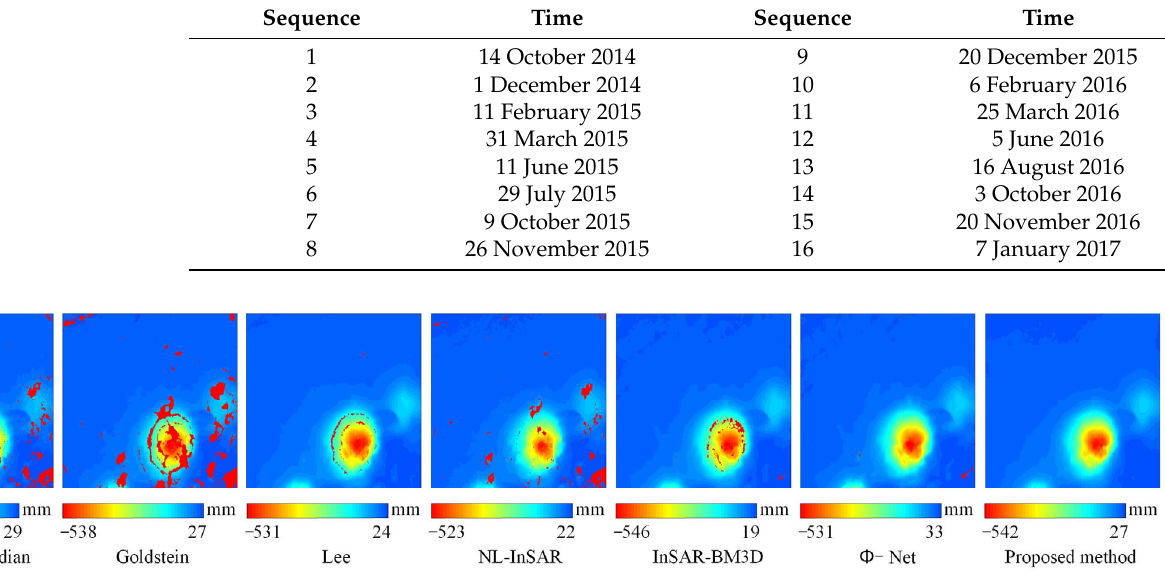
Table 3. SBAS-InSAR data selection.